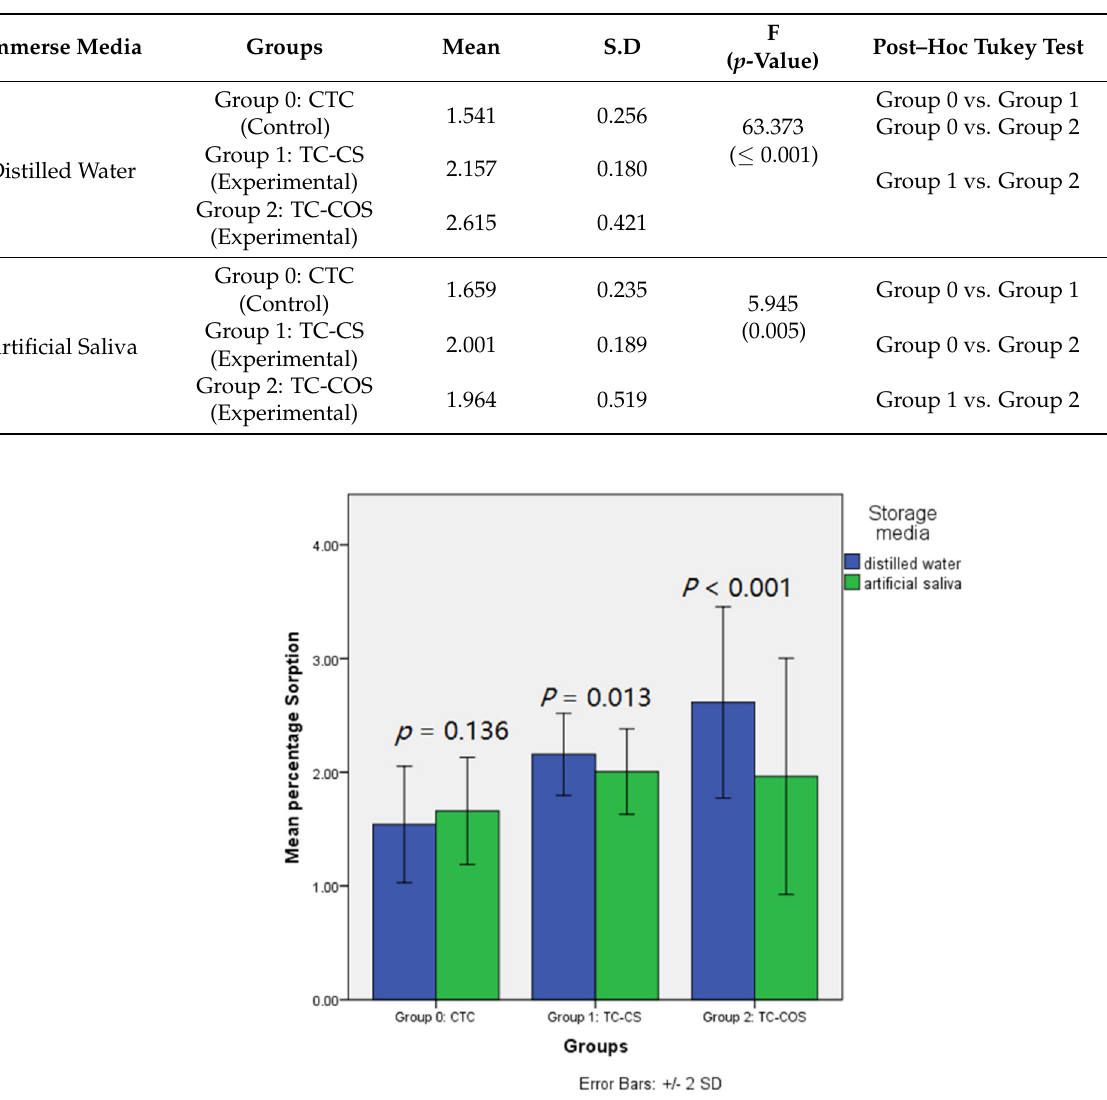
Figure 4. Mean percentage absorption upon aging in distilled water and artificial saliva. Table 1. Comparison of tissue conditioner stored in distilled water and artificial saliva based on percentage sorption of specimens.